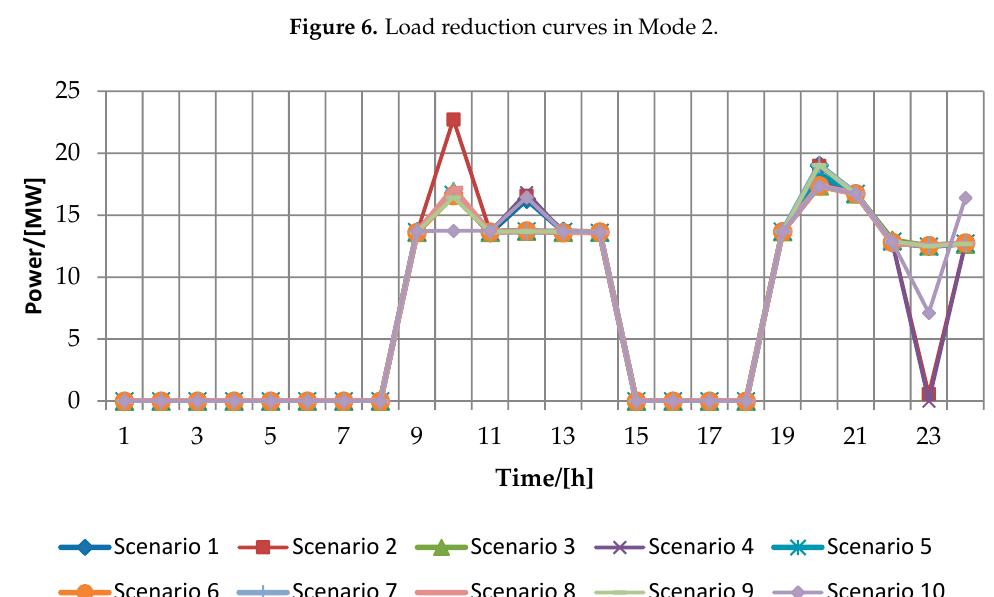
Figure 7. Load reduction curves under different scenarios (the values of K 1 in the first- and second-type air-conditioning load (ACL) are 1 and 0.9, respectively).